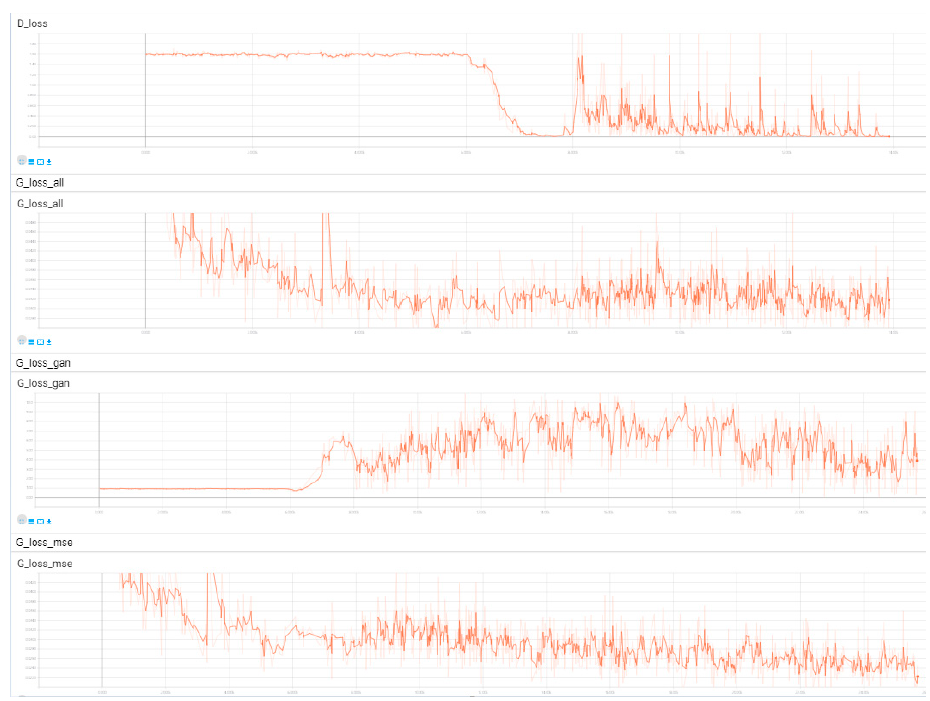
Figure 8. The losses graph of this method’s network structure.